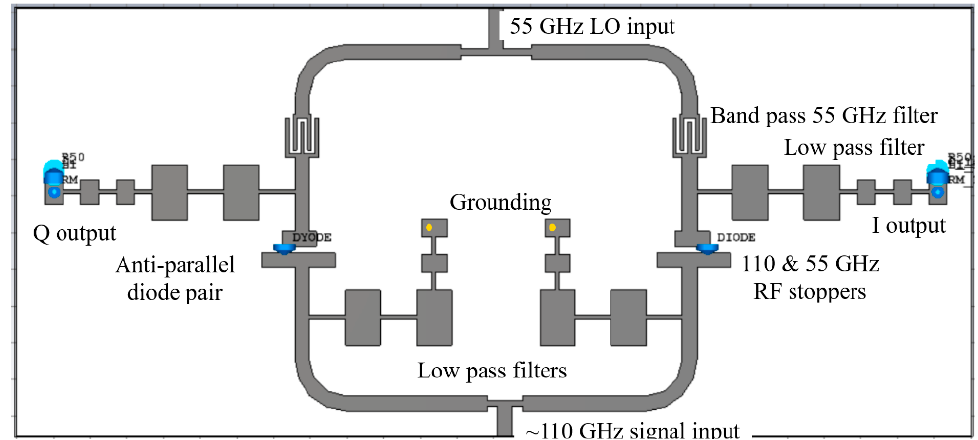
Figure 6. Quadrature mixer layout. Top microstrip port is for 55 GHz input from a local oscillator, bottom microstrip is for signal input at around 110 GHz. At 110 GHz the difference in length of the left and right microstrip transmission lines from the splitter to the mixer diodes results in a 90-degree relative phase difference at the mixers.